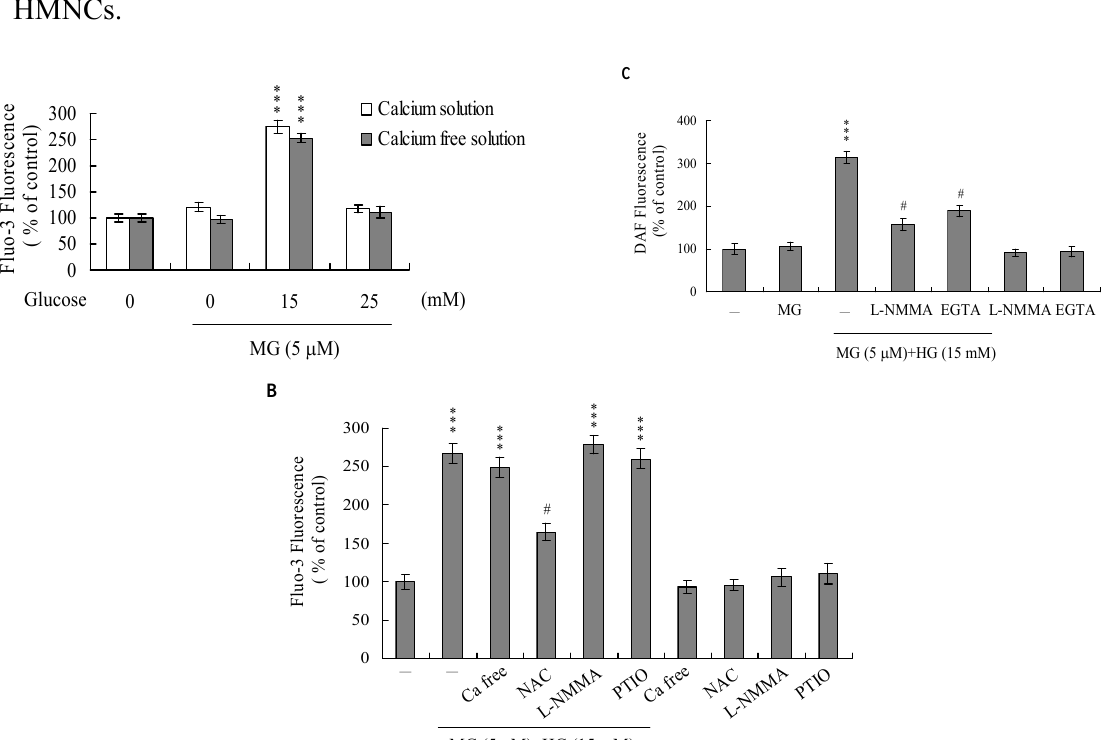
Figure 4. MG/HG co-treatment triggers changes in intracellular calcium and NO content in